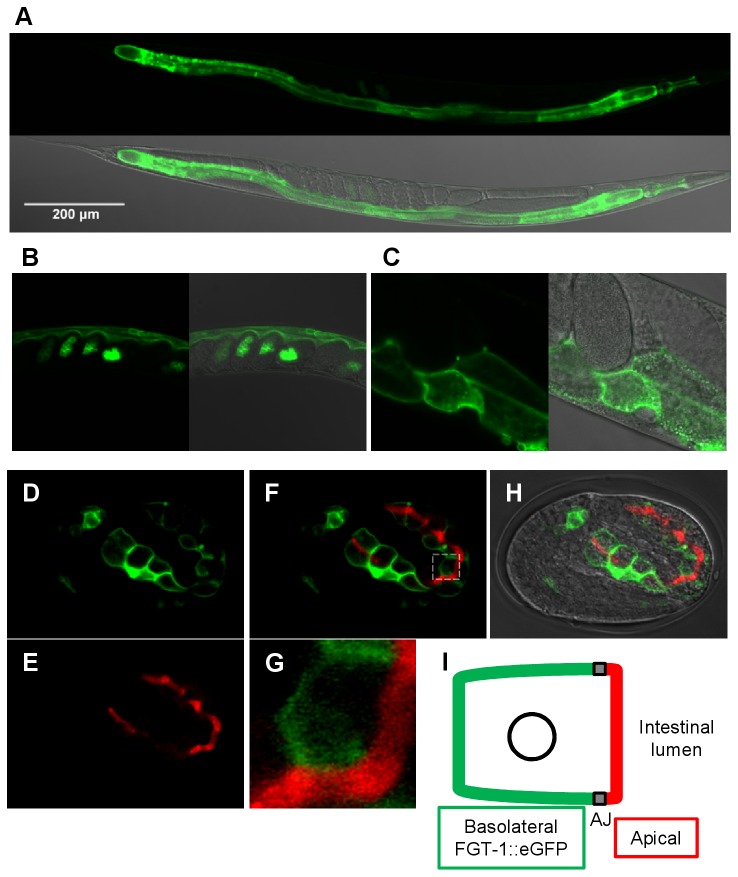
Cellular and subcellular localizations of FGT-1 in C. elegans.The fgt-1::egfp fusion construct under the control of the fgt-1 promoter was injected into C. elegans, and the expression of the FGT-1::eGFP fusion protein was visualized with a confocal laser microscope. A: whole animal, B: embryos inside of a parental worm, C: higher magnification image of mid-body. For each panel (A to C), GFP fluorescence was shown alone or as a merged picture with differential interference contrast (DIC) images. D–H. Immunostaining of the apical membrane marker IFB-2 for fgt-1::egfp embryos. Subcellular localizations of FGT-1::eGFP (green) and IFB-2 (red) were observed under a confocal laser microscope. D: FGT-1::eGFP, E: IFB-1 immunostaining. F: Merged image of D and E.G: The higher magnification of the white box area in F.H: Merged image of eGFP fluorescence and DIC images. I. Schematic diagram of an intestinal cell with subcellular localizations of eGFP (green) and IFG-2 (red). The potential adherent junction (AJ) is indicated by a dark box.